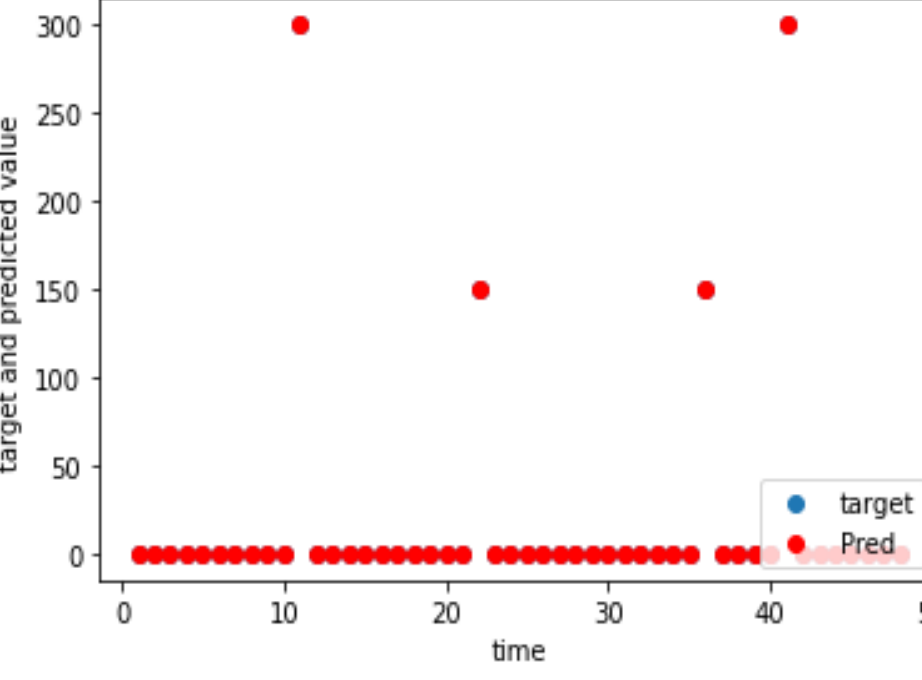
Figure 10. Charging demand prediction of a weekend for Hyljeveneentie.